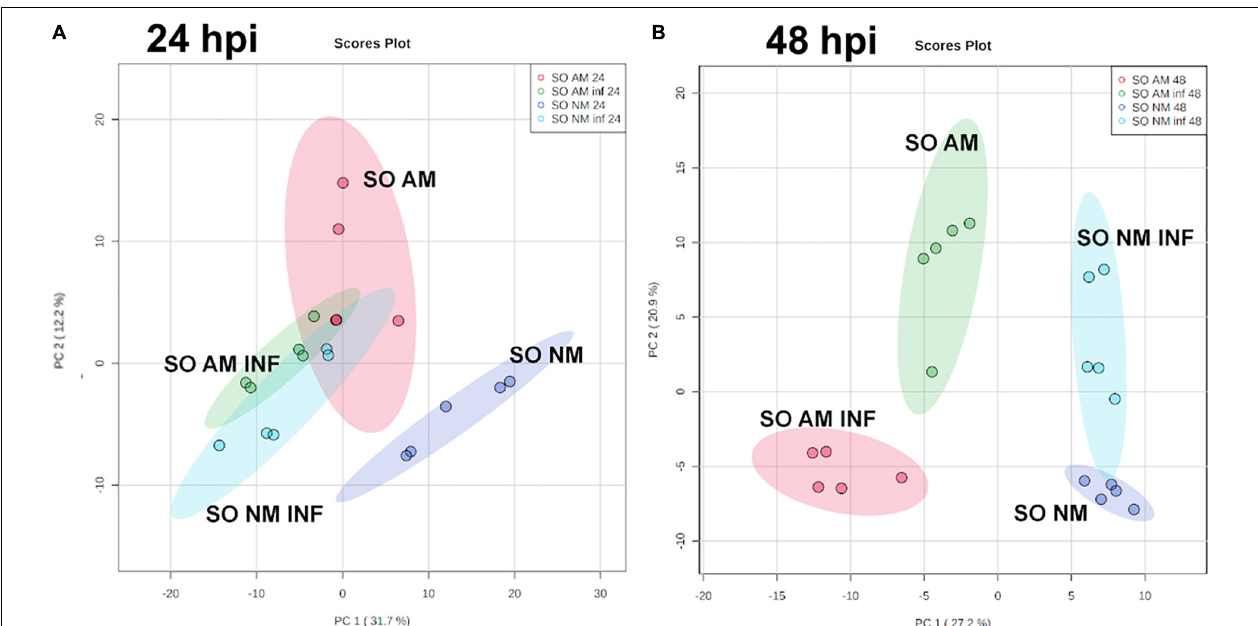
FIGURE 4 | Impact of mycorrhization on the metabolic profile of locally infested leaves of C. aurantium plants. Non-targeted principal component analysis (PCA) obtained from a non-target analysis by UPLC-QTOFMS of locally infested leaves at (A) 24 h post infestation and (B) 48 h post infestation with T. urticae. 3 months old plants were infested with five 2-days-old female T. urticae (2 leaves per plant). 24 or 48 h after infestation, infested leaves were detached and frozen at –80 ◦ C. A pool from 6 individual plants was employed for each combination. Three independent and two technical replicates were randomly performed (n = 5). Four different treatments were analyzed: NM: non-mycorrhizal non-infested plants. AM: mycorrhizal non-infested plants. NM inf: non-mycorrhizal infested plants. AM inf: mycorrhizal infested